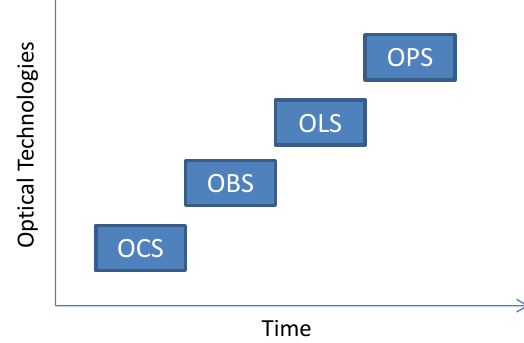
Figure 8. Optical switching technologies sorted by complexity/performance and hypothetical phases of implementation.